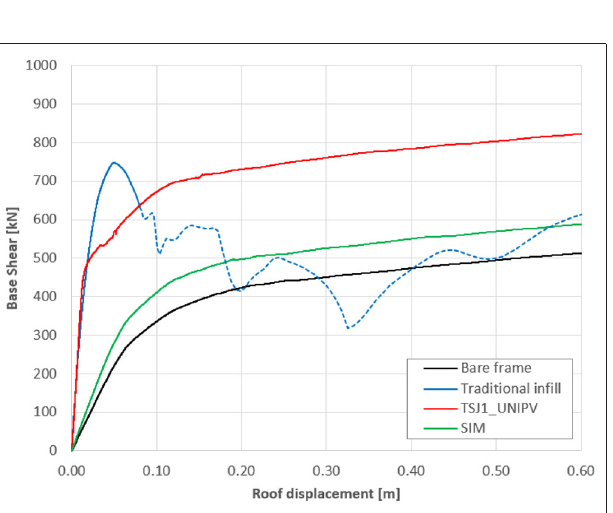
the bay of the considered building. Instead, for the mechanical interlocking SIM panel MO, the calibrated values have been properly scaled according to the bay dimension of the frame.